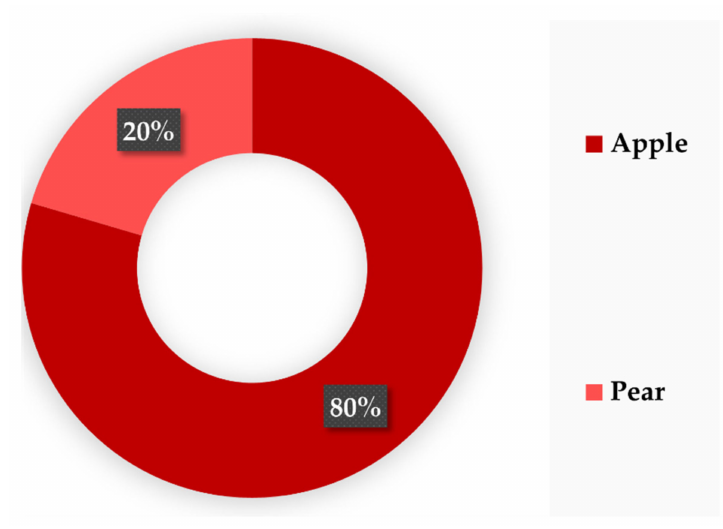
Figure 5. Proportion of pome production in